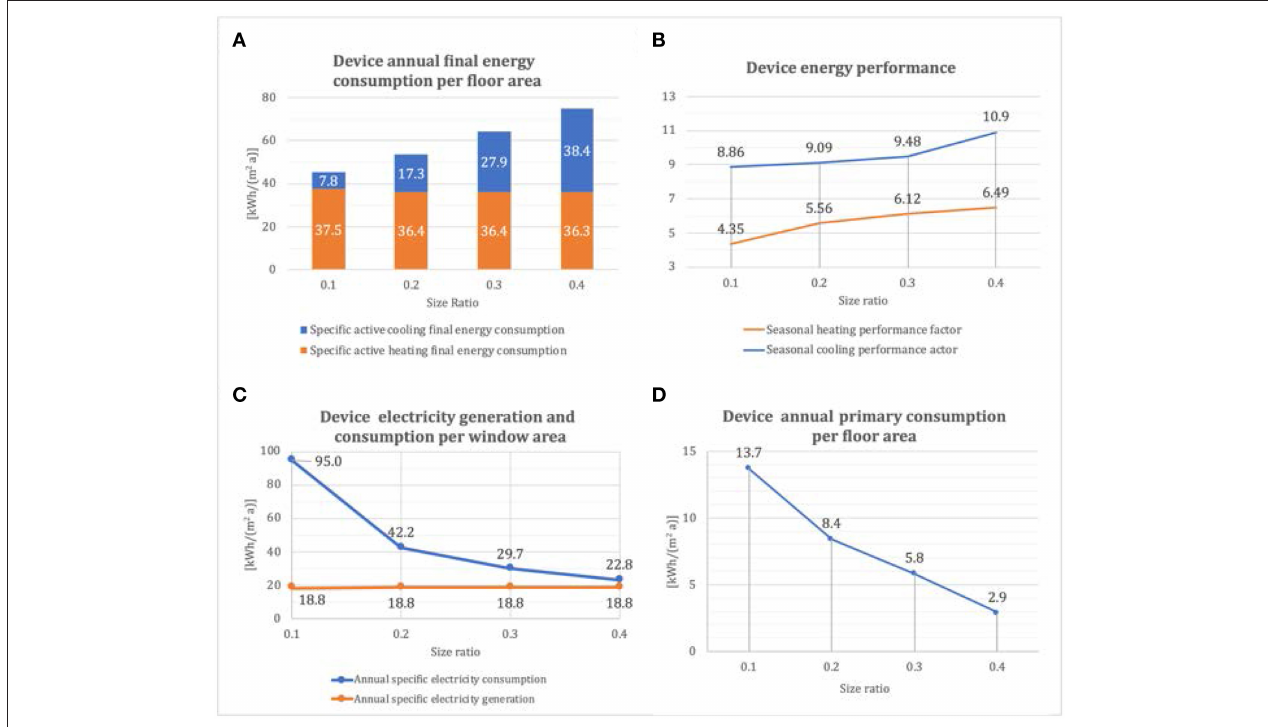
FIGURE 11 | Final energy consumption (A) , energy efficiency (B) , electricity generation and consumption (C) , and primary energy consumption (D) for a highly-occupied office room and variable window-to-floor area ratios, implementing fluidic IGUs (see text for details).